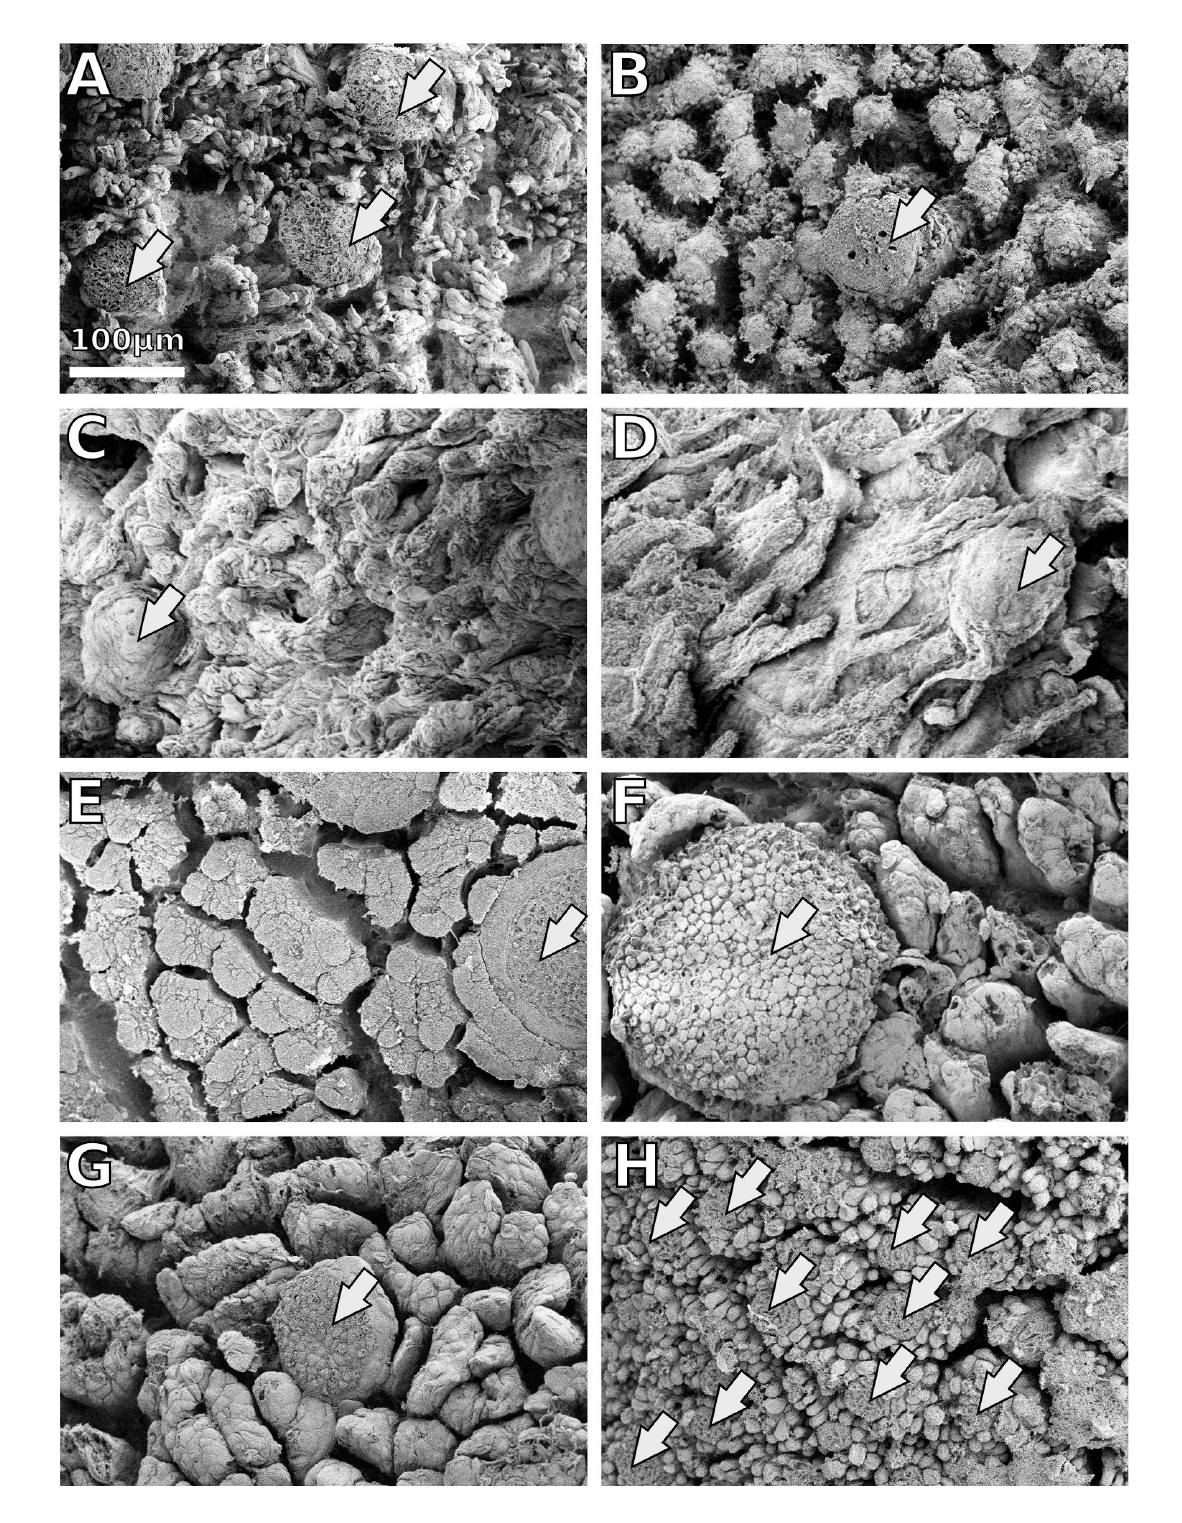
Figure 1: Scanning electron microscopy of frog tongue surfaces. All images are at the same scale. A – Bombina variegata , B – Discoglossus pictus , C – Ceratophrys ornata, D – Litoria infrafrenata , E – Megophrys nasuta, F – Rana (Lithobates) pipiens , G – Bufo bufo , H – Oophaga histrionica . Frog tongue surfaces are covered by fungiform papillae (arrows), which are embedded in a matrix of smaller filiform papillae. The examined species differ notably in the size and the shape of the papillary surface